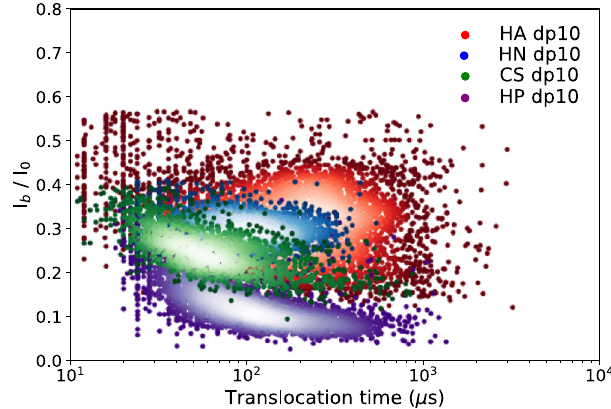
Fig. 7 | Superimposed scatter plot of events observed with dp10 oligo- saccharides ofhyaluronic acid (HA), heparosan(HN), chondroitin sulfate (CS), heparin (HP). It shows the differences between the various families of oligo- saccharides observed in this study. They vary by their osidic bond (HA vs HN), building block (HA vs CS) or degree of sulfation (HP vs HN). The timescales of translocation and the blocked current are different for each species and the event cluster are distinguishable, establishing a fi ngerprint of these oligosaccharides. All the experiments were performed using similar experimental conditions: 4M LiCl, 25mMHEPESbufferand 1.0mMEDTAatpH7.5,20.0°C,and atthebiasvoltageof +60mV. Concentrations of HN and HA dp10 were 100 μ M, and HP and CS dp10 were 43 μ M. Source data for this fi gure are provided as a Source Data fi